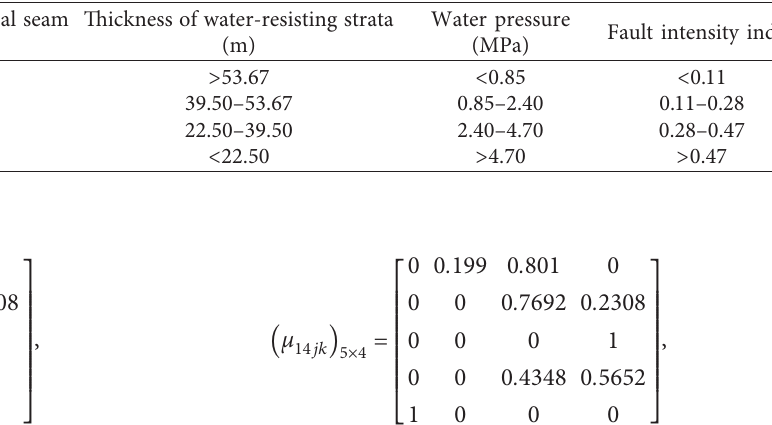
Table 5: The index risk grade